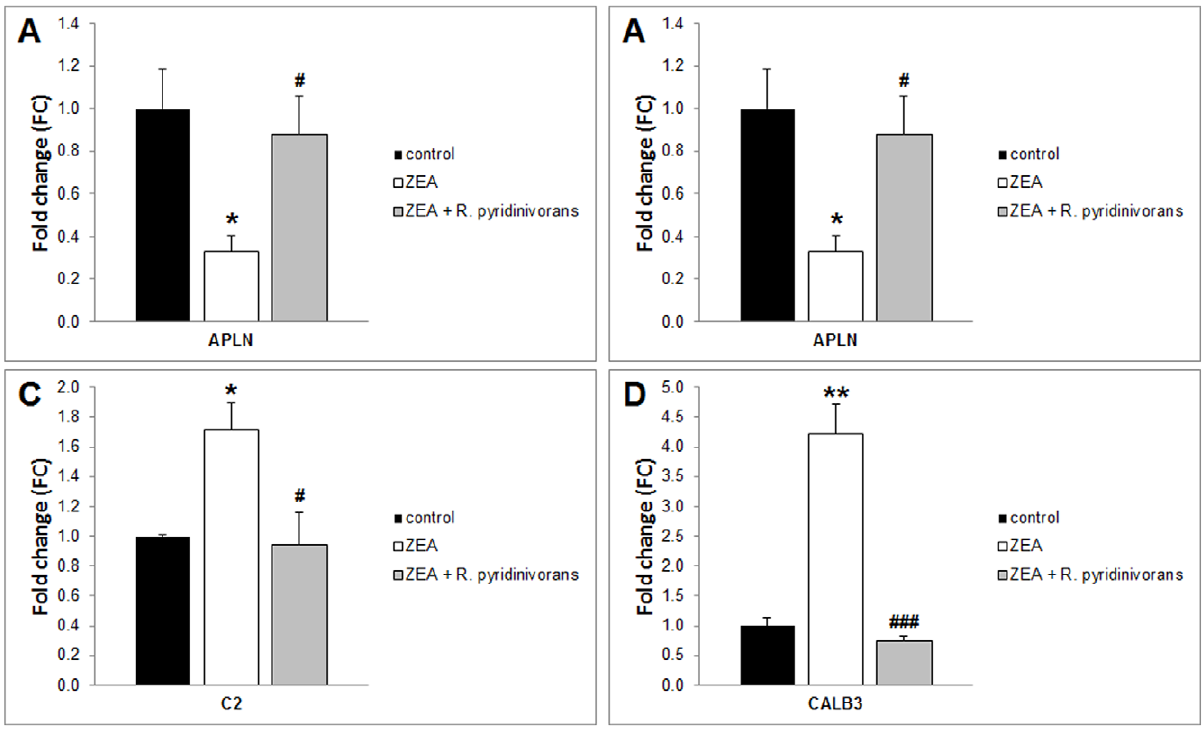
Figure 5. Gene expression of apelin, aquaporin 5, complement component 2, and calbindin 3 in Experiment2 . Gene expression of apelin (APLN) and aquaporin 5 (AQP5) decreased and complement component 2 (C2) and calbindin 3 (CALB3) increased significantly after 3-day ZEA treatment. There is no significant difference between control and ZEA + R. pyridinivorans K408 treatment in folding changes. (*) Significantly different from control (p , 0.05). (**) Significantly different from control (p , 0.01). ( # ) Significantly different from ZEA (p , 005). ( ### ) Significantly different from ZEA (p , 0,001) (n=6–7).